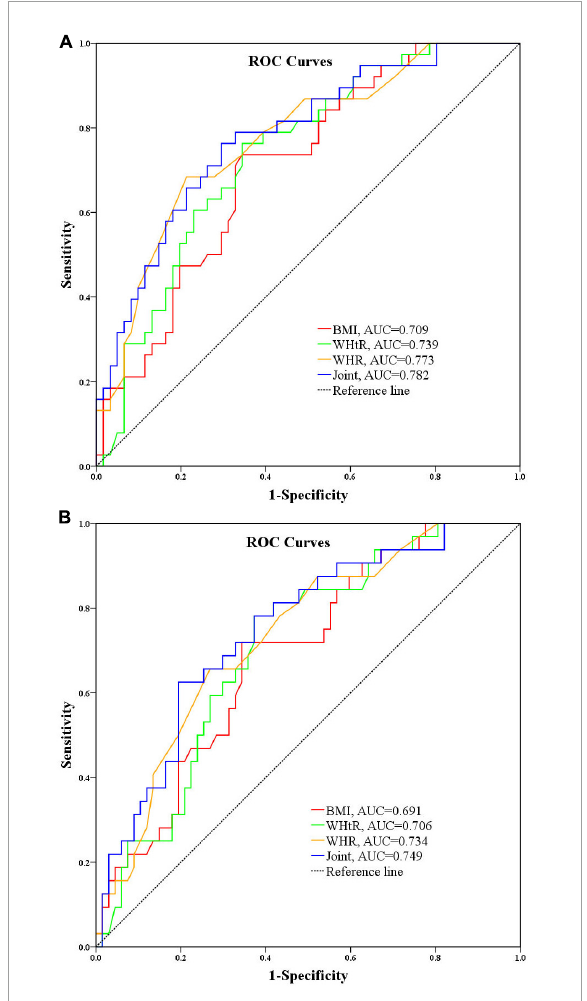
FIGURE4 (A) Performance analysis of BMI, WHR, and WHtR for identifying moderate risk of AIP. (B) Performance analysis of BMI, WHR, and WHtR for identifying high risk of